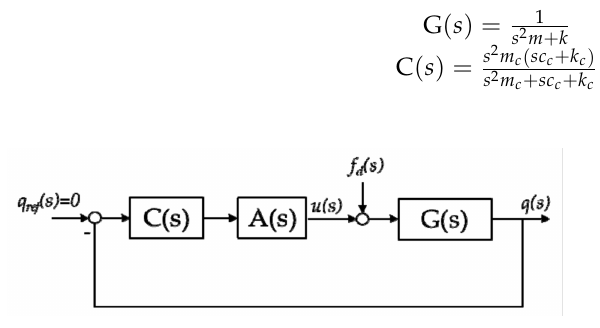
Figure 14. A sketch of the closed-loop system with